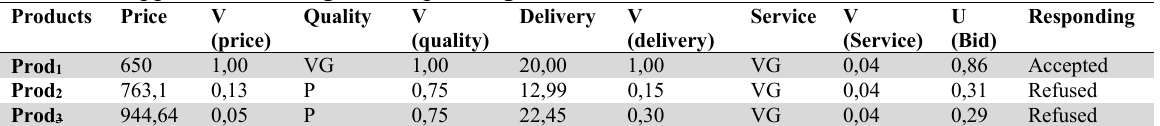
Round 2: Supplier Conceding and responding